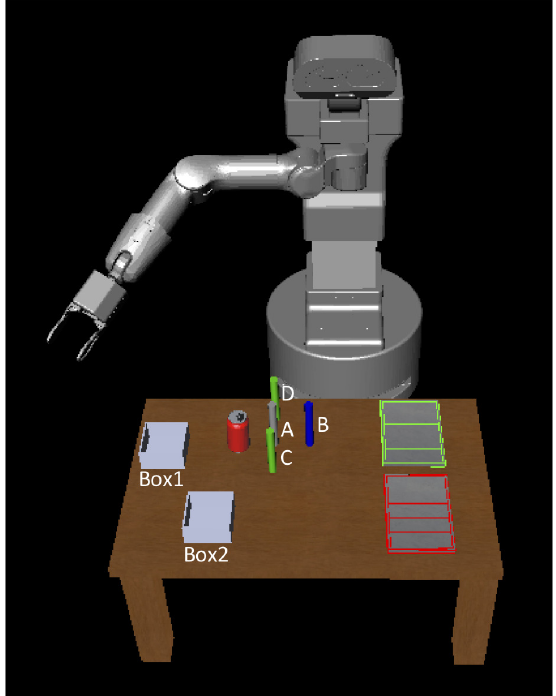
Figure 4. The manipulation example where the goal is to transfer cylinder A to one of the trays with respect to its